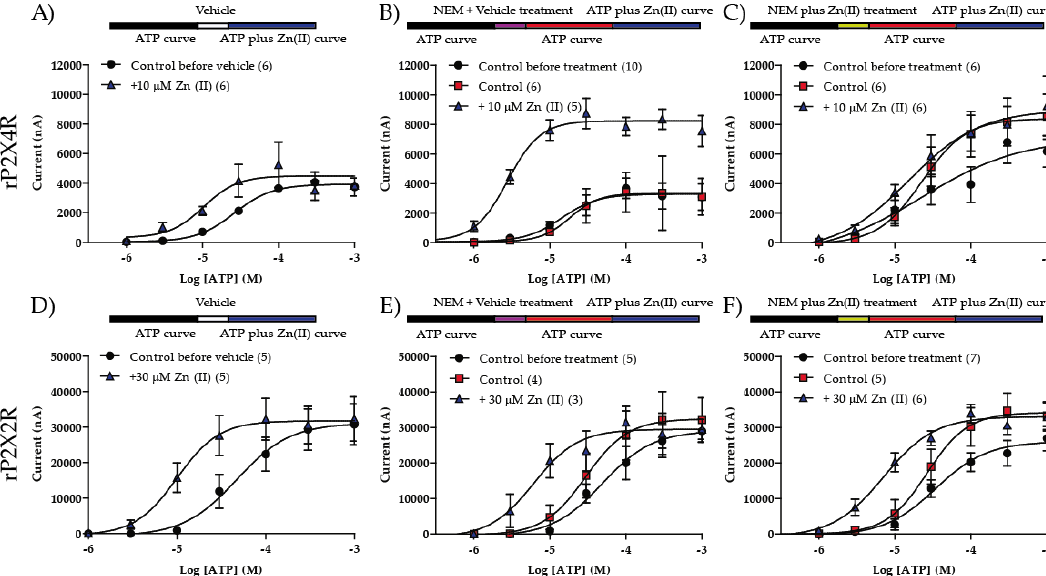
Figure 1. NEM treatment in presence of Zn(II) abolish metal modulation in rP2 × 4R but not on rP2 × 2R. The protocol consist on a full ATP concentration–response curve (black bar in protocols and black filled circles in graphs) followed by a 5 min treatment (vehicle = white, NEM + vehicle = purple, NEM + Zn(II) = yellow) and 20 min washout and finally a full ATP concentration–response curve in absence (red bar in the protocols and red filled squares in graphs) or presence of Zn(II) (blue bar in the protocols and blue filled triangles on graphs). ( A ) Vehicle treatment on rP2 × 4R, ( B ) NEM treatment on rP2 × 4R, ( C ) NEM + Zn(II) treatment on rP2 × 4R, ( D ) vehicle treatment on rP2 × 2R, ( E ) NEM treatment on rP2 × 2R and ( F ) NEM + Zn(II) treatment on rP2 × 2R. Circles, squares and triangles represent ± SEM. N is indicated in parenthesis on each graph. Table 1. Pharmacological characterization of the wild type rP2 × 4R and rP2 × 2 before and after NEM or NEM + Zn(II) treatments.